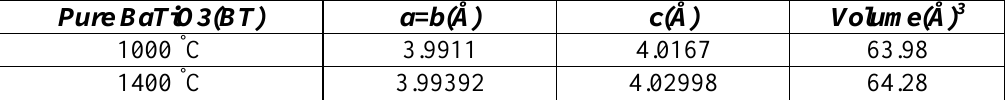
Table 1: Lattice parameter of Pure BaTiO